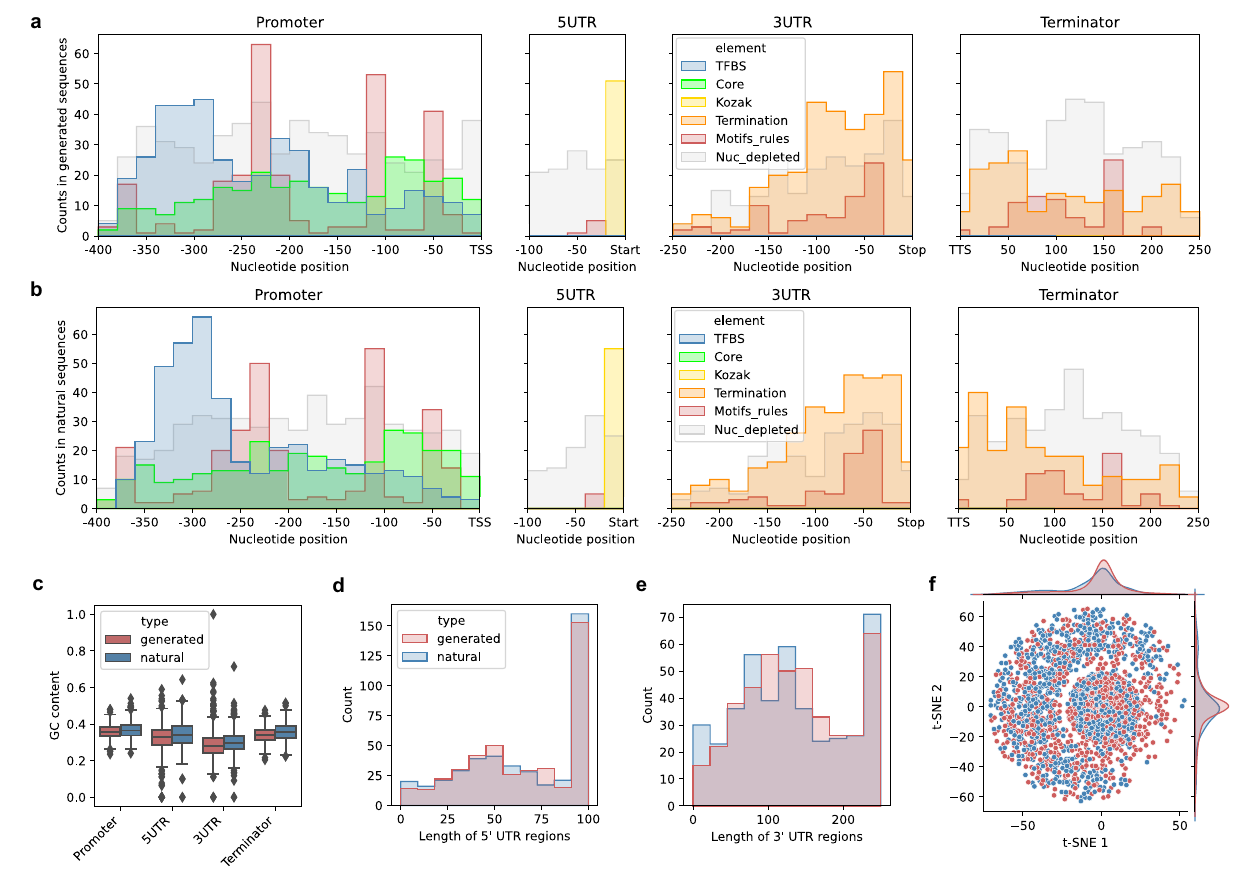
Fig. 2 | Deep learning-generated sequences exhibit properties of natural reg- ulatory DNA. a , b Cumulative positional distribution of known DNA regulatory grammar elements (see Fig. 1a) across the regulatory regions of a generated syn- theticand b naturalsequences( n =425each).ShownareyeastTFBS 48 identi fi ed( q - value<0.05) using FIMO 49 (blue) and TATA core promoter elements 50,51 (green) in promoters, Kozak sequences 52,53 in 5 ′ UTRs (yellow), termination related motifs (positioning,ef fi ciencyandpoly-ATmotifs) 6,54 in3 ′ UTRsandterminators(orange), and deep learning-uncovered expression-related motifs and motif association rules 7 (red) as well as nucleosome depletion 55,56 (gray) across all regions. Note that theamountofKozaksequencesandnucleosomedepletedpositionsarenotshown to scale, with 4-fold and 200-fold dilutions, respectively, to improve visualization (see separate comparisons across elements in Supplementary Fig. 3). TSS denotes